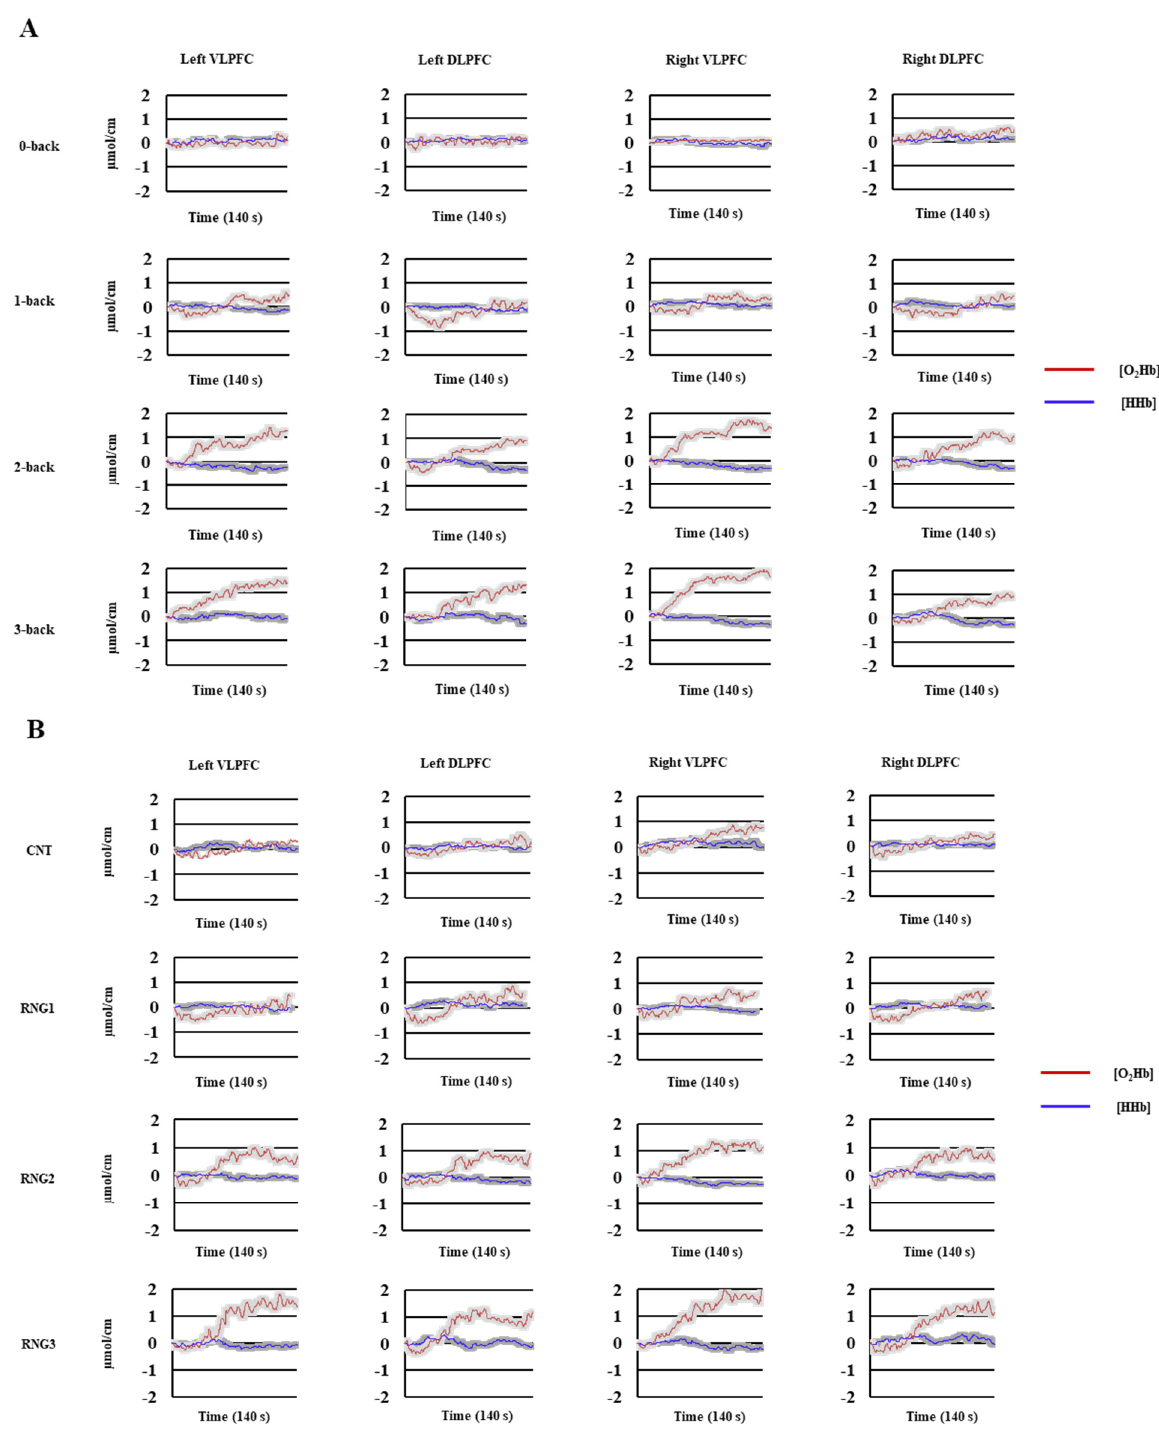
Figure 1. Mean hemodynamic activity as a function of cognitive load, hemisphere, and channel. ( A ) = n-back; ( B ) = RNG (random number generation). The colored frames on the curves correspond to the standard error of the mean; VLPFC = ventrolateral prefrontal cortex; DLPFC = dorsolateral prefrontal cortex.